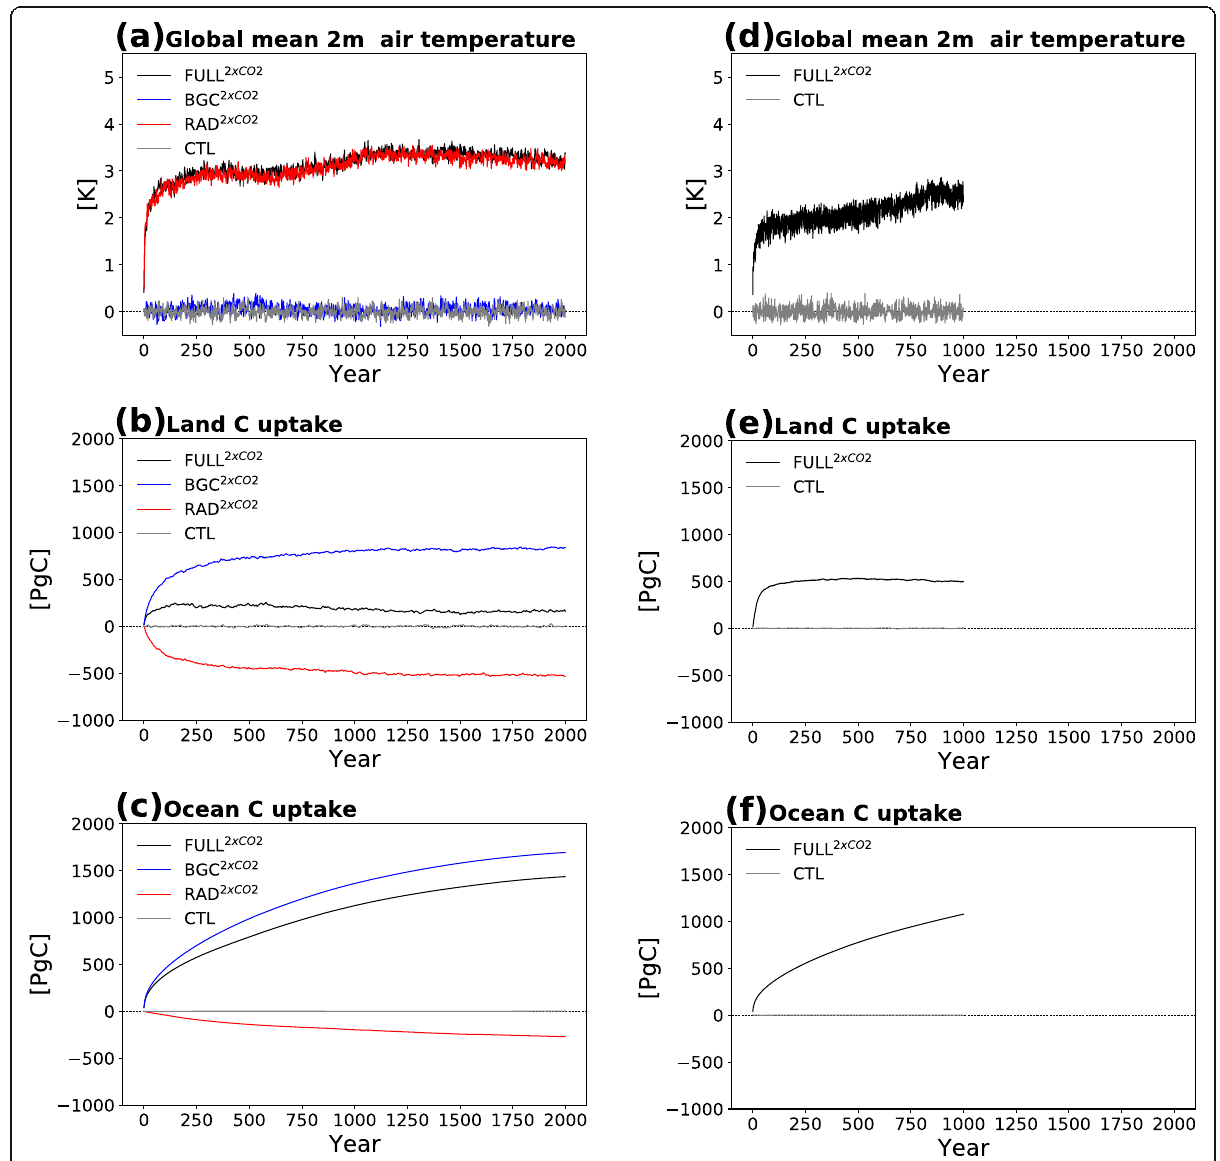
Fig. 1 Change in temperature ( Δ T) (top) and changes in cumulative land (middle) and ocean (bottom) carbon (C) uptake in the millennium time- scale experiments. Left a – c panels present the simulation results from MIROC-ESM; FULL 2 × CO2 (black), BGC 2 × CO2 (blue), and RAD 2 × CO2 (red), where atmospheric CO 2 concentrations are abruptly doubled and held constant over 2000 years. Right d – f panels present the results from MIROC-ES2L with the results from FULL 2 × CO2 over 1000 years. The control experiment of each model is shown by the gray line. All simulation results were detrended by the control run of each model, by fitting spline curves over